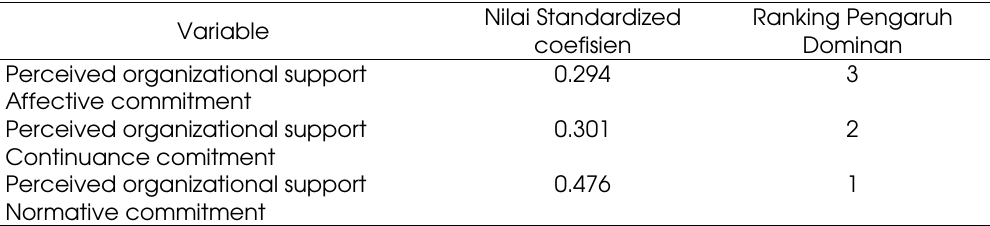
Path coefficient score for each of the